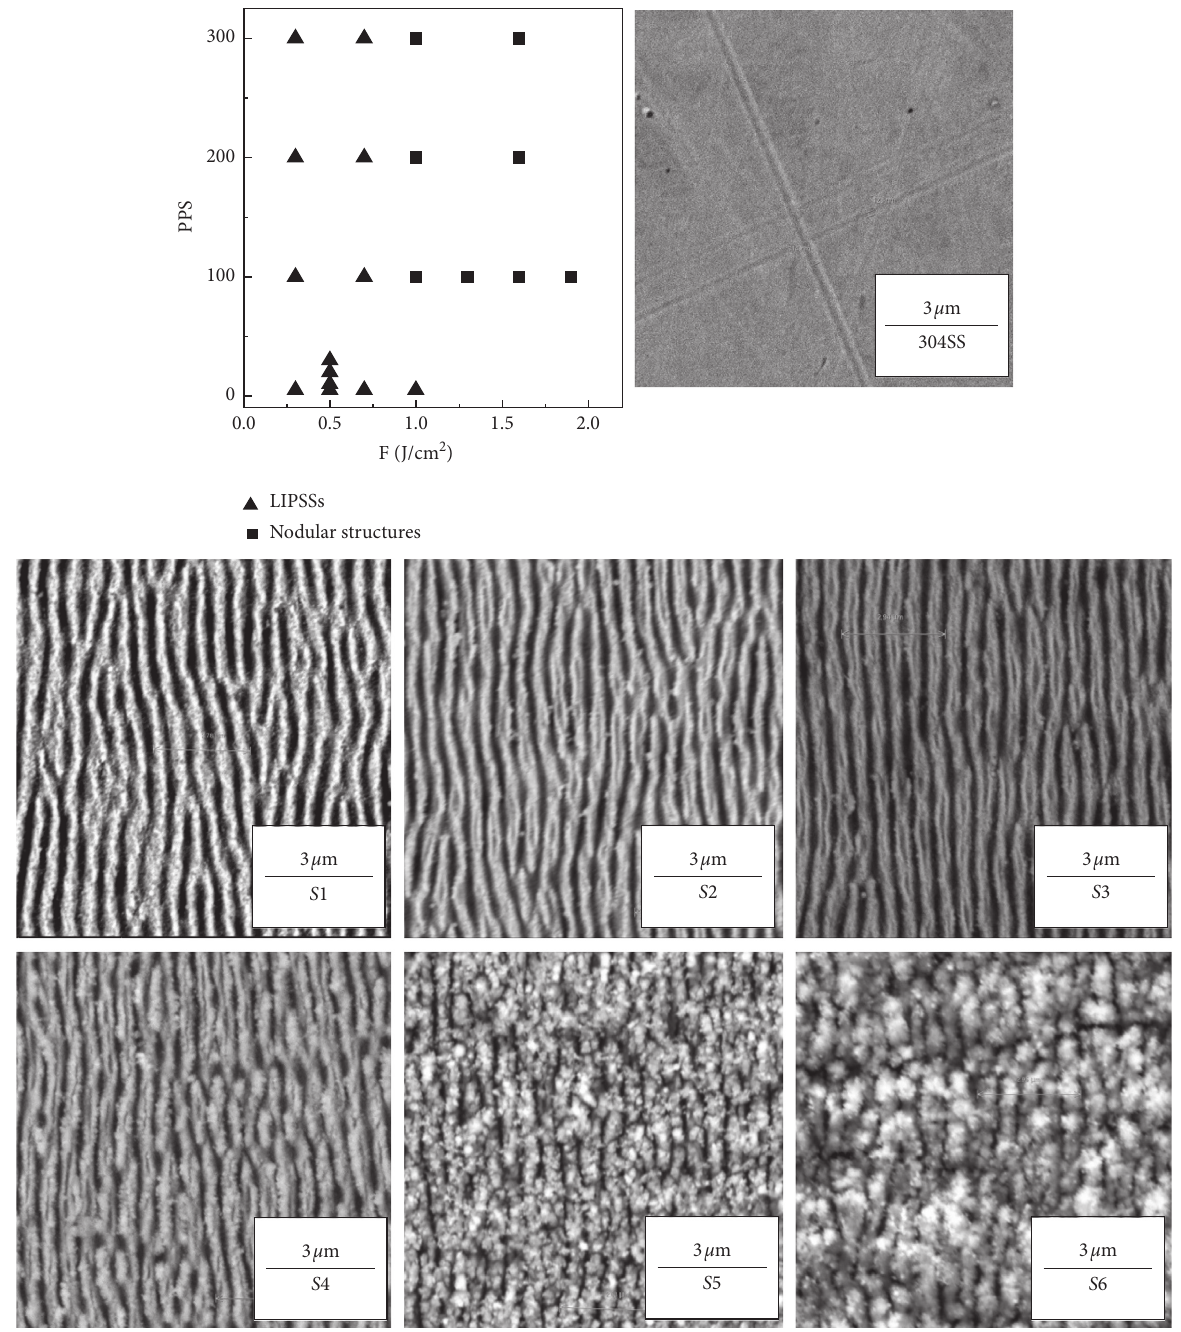
Figure 1: The influence of F and PPS on the evolution of surface morphology. PPS refers to the pulse number per focal spot and F refers to the pulse fluence. S 1– S 3 have the same F � 0.5J/cm2 with increasing PPS � 5, 10, and 20 pulses, respectively, and S 4– S 6 have the same PPS � 100 pulses with increasing F � 0.5, 1.5, and 2.0J/cm2, respectively. Surface morphology of 304SS is also given for comparison purpose. Table 1: Surface free energies and CAs of specimens after laser